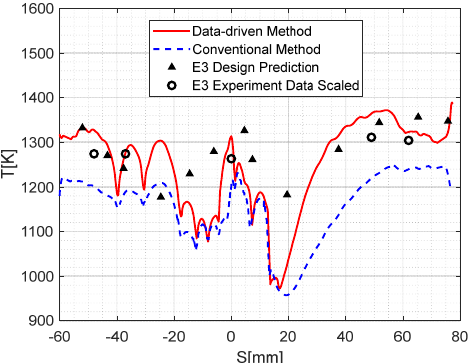
Figure 9. External surface temperature distribution of the middle section [24,25].